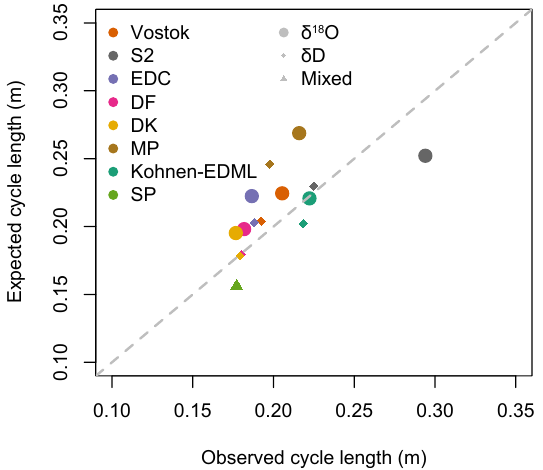
Figure 5. Comparison of expected and observed cycle length for all sites. The cycle length is evaluated between 1 and 4m snow depth (or the maximum depth for shallower snow pits). Results are shown separately for δ D and δ 18 O except for SP, where a combined value is used since here δ D and δ 18 O are not available from the same profiles. The expected cycle length is directly derived from the dif- fusion length assuming a pure white noise surface signal. Note that cycle lengths are larger than those provided in Fig. 3 as the first metre is excluded from this